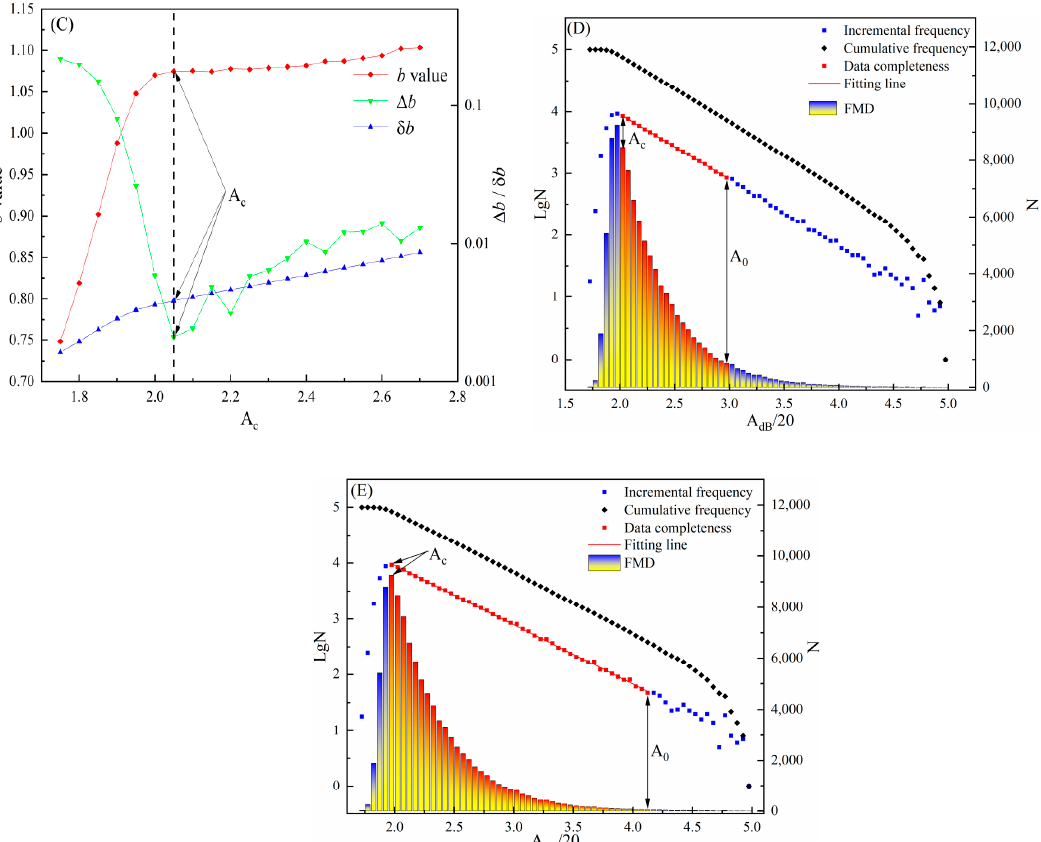
Figure 2. Schematic of five methods for determining the completeness amplitude. The amplitude data are the synthetic AE catalog generated by Section 2.1. ( A ) MAXC. ( B ) GFT, the figure shows the variations of residuals and goodness-of-fit with A c , and the horizontal dashed lines indicate 90% and 95% confidence. ( C ) MBS, b value, ∆ b , and δ b variations trend with cut-off amplitude, the vertical dashed line is A c determined by MBS method. ∆ M = 0.05, d M = 0.25. ( D ) MBASS. ( E ) FGS.